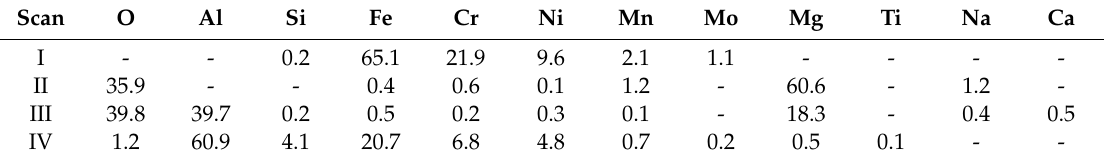
Figure 11. SEM micrographs of the C_0 composite crucible after the corrosion test with molten AlSi7Mg0.3 aluminum alloy at 850 ◦ C: ( a ) image magnified to 30 × ; ( b ) image magnified to 300 × . Table 10. Results of EDS scans corresponding to areas indicated by arrows in Figure 11 (in at %).